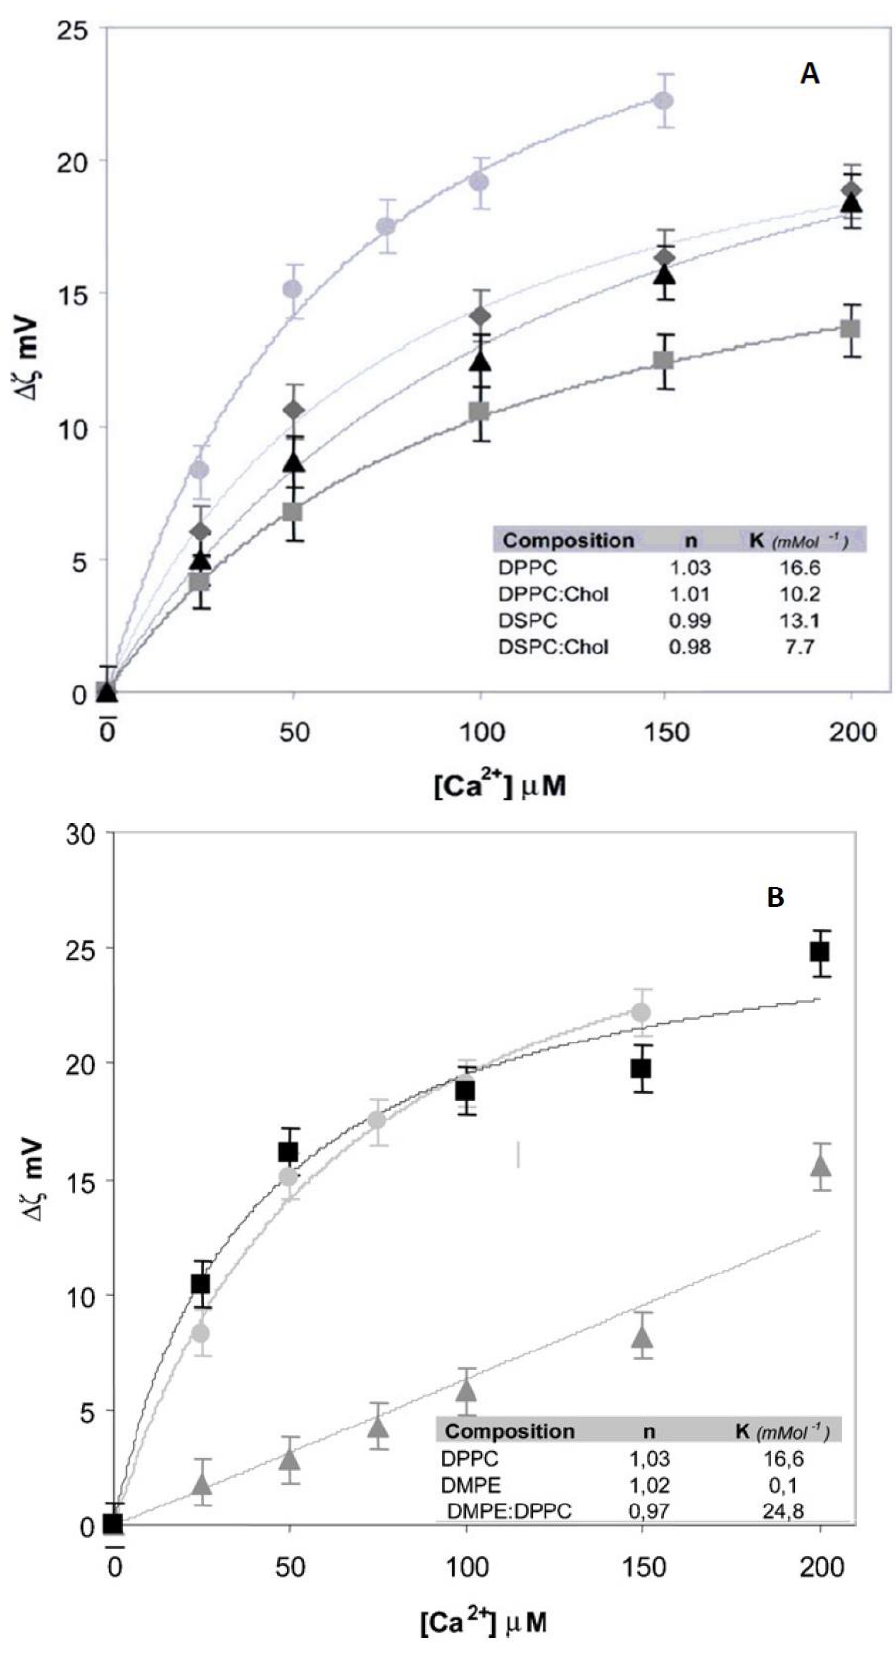
Figure 3. Changes of zeta potential induced by Ca 2+ . ( A ) Effect of acyl chain and cholesterol, DPPC (